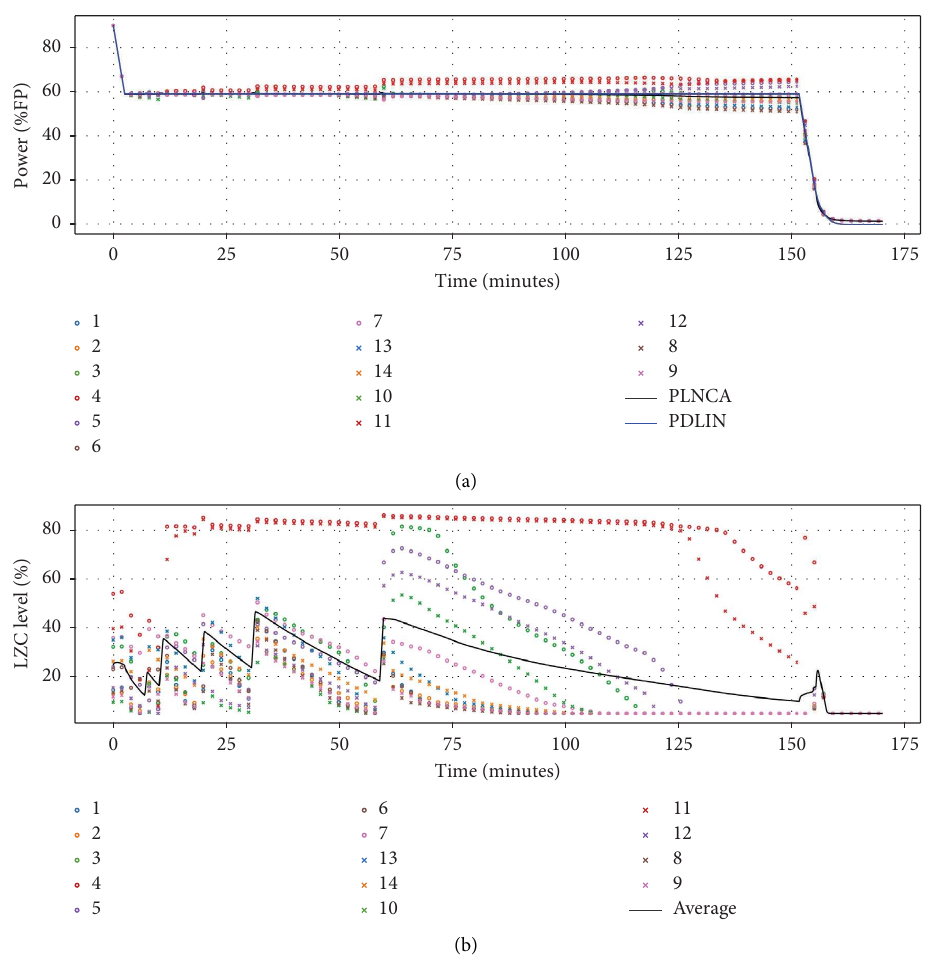
Figure 7: Evolution of fnal phase of simulated shim operation: reactor/zone powers (a) and liquid zone levels (b). Table 3: Efect of adjuster depletion on reactivity device worths (in